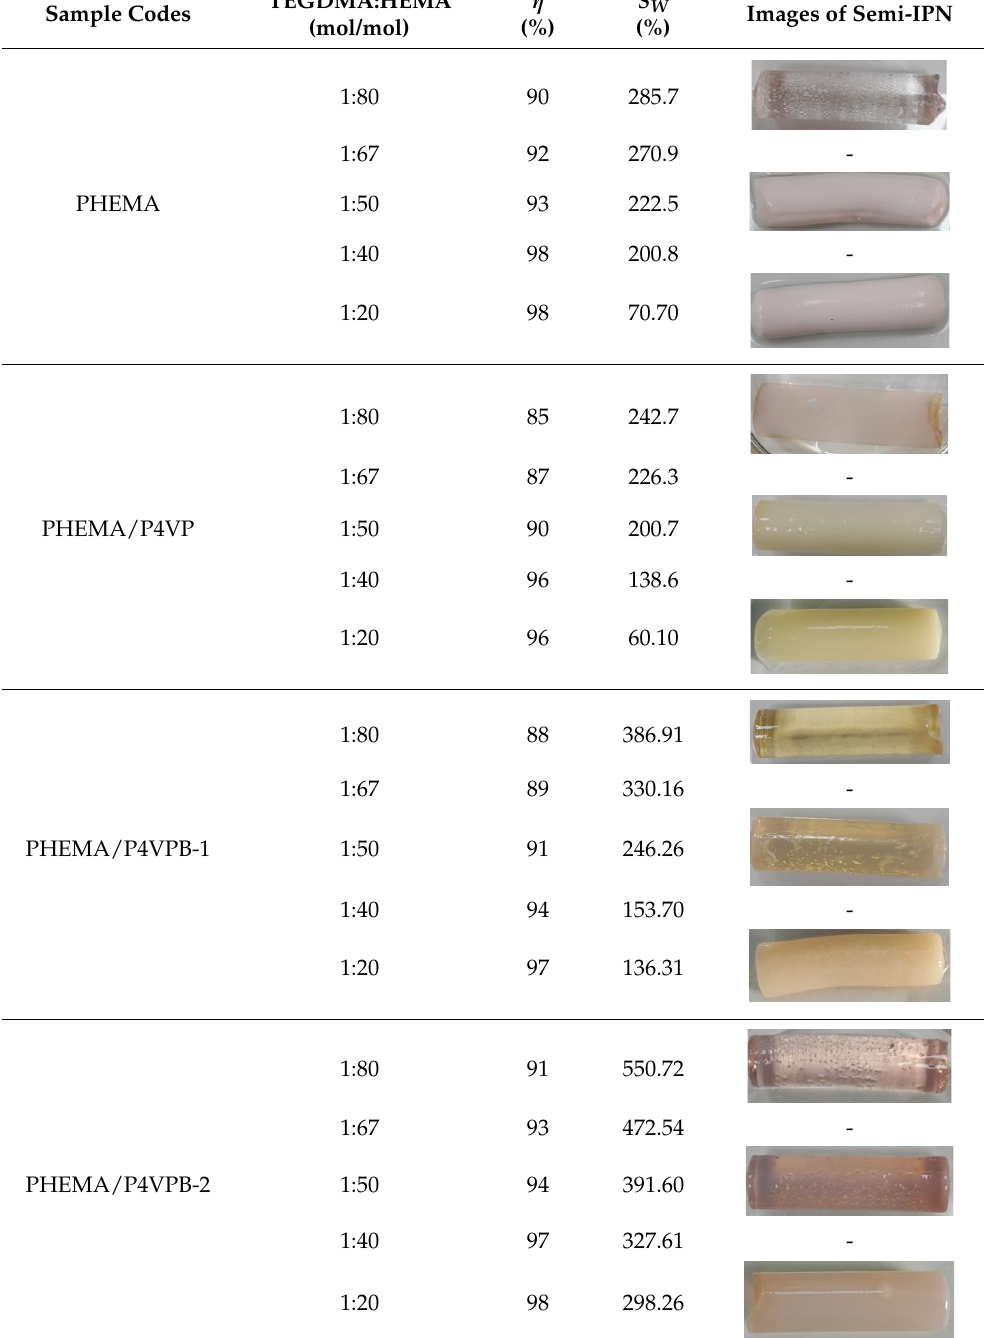
Table 1. Values of η , maximum swelling degree in water and optical images of PHEMA, PHEMA/P4VP, PHEMA/P4VPB-1 and PHEMA/P4VPB-2 networks at different molar ratios HEMA: TEGDMA .